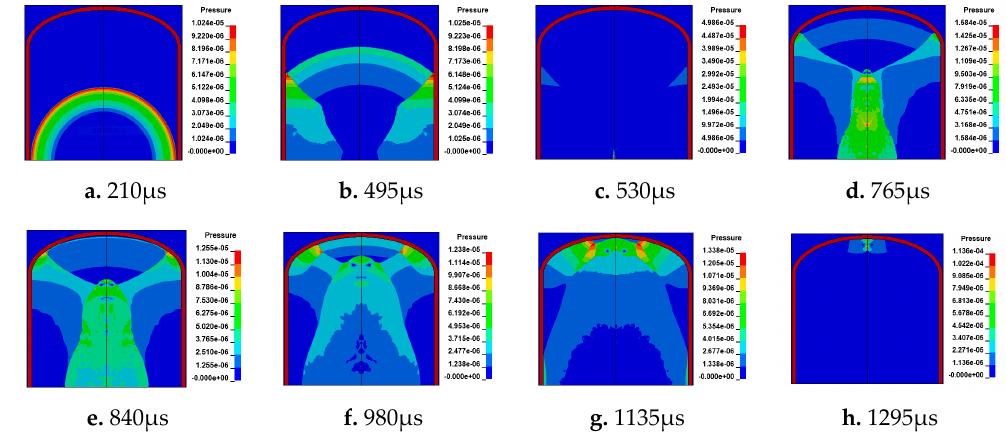
Figure 5. Internal explosion nephogram under the 2.025 vessel aspect ratio.